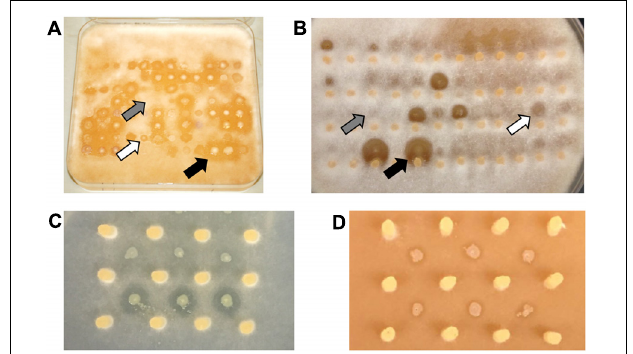
FIGURE 2 | Antagonistic activity against oomycetes and loss of killing phenotype. Photograph of antagonistic assay of (A) 96 and (B) 60 water strains against P. sojae and P. sylvaticum, respectively. All bacterial isolates were competed against five oomycetes on V8 medium. Gray, white, and black arrows indicate no, weak, and strong antagonistic activity, respectively. (C) Wildtype strain 06C 126 (bottom row) and qbs mutant (top row) showing loss of antagonistic activity on GCA medium. A zone of clearing is observed with the wildtype strain and absent from the mutant. (D) Wildtype strain 06C 126 (bottom row) and transposon mutant (top row) exhibiting antagonistic activity on V8 medium. A zone of clearing is observed around the wildtype and mutant strains. Yellow plugs in (B–D) represent the source of P. sylvaticum